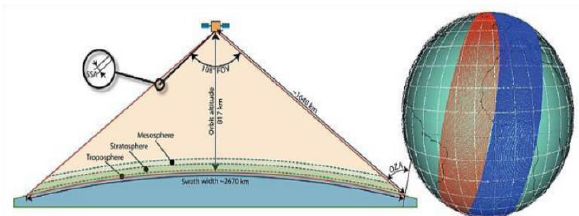
Figure 1. right: footprint of image swath and left: global representation of image swath (courtesy ESA).